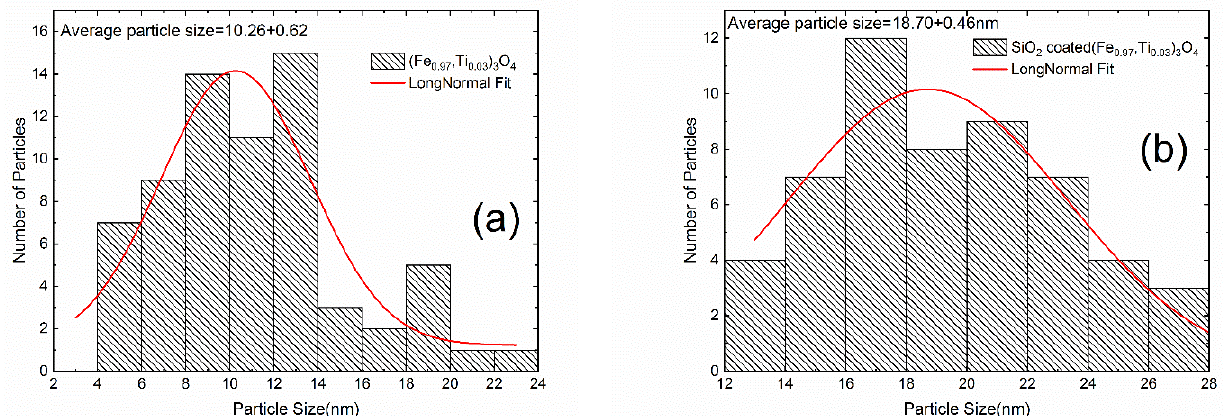
Figure 4. Calculated size distributions of ( a ) uncoated and ( b ) coated (Fe 0.97 ,Ti 0.03 ) 3 O 4 nanoparticles via ImageJ subprogram.